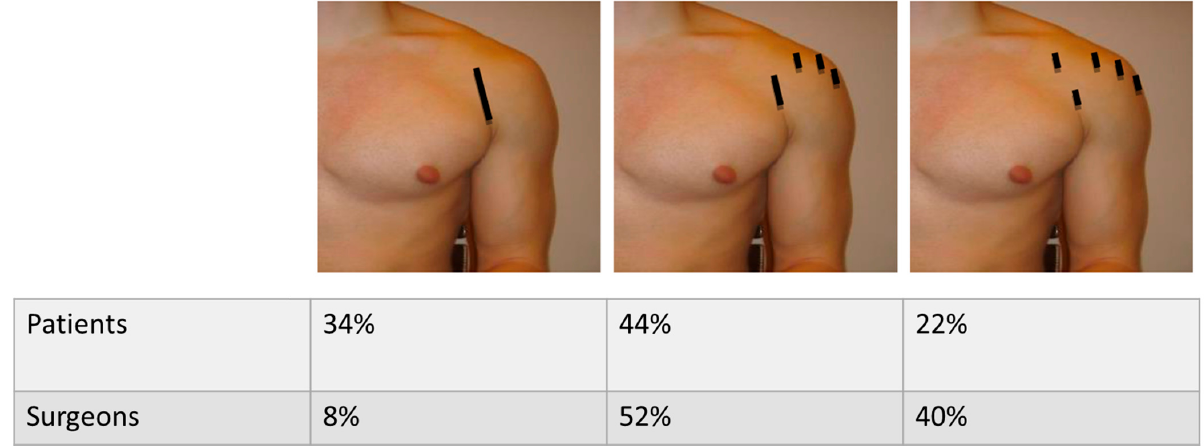
Figure 3. Scars (black lines) patients would prefer for instability repair and what surgeons keep in mind ( p = 0.005, r = 0.193). Table 1. Correlation coefficients of the HSS and patients’ preoperative data (* p ≤ 0.05, ** p ≤ 0.01, n.s. = no significance). stability. Daytime